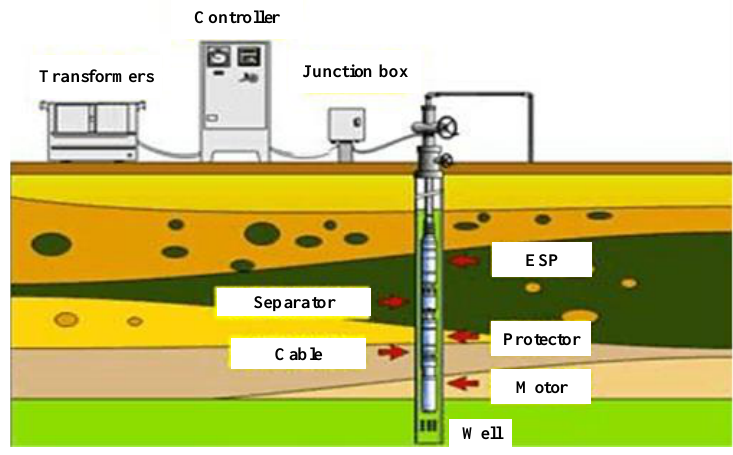
Figure 1. Electrical submersible pump (ESP) assembly and components.